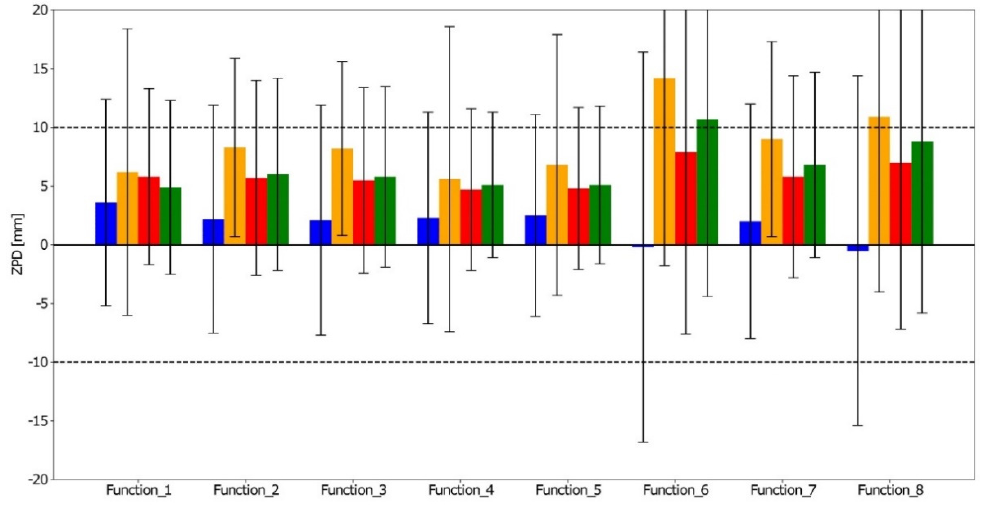
Figure 10. Mean accuracy of the ZPD with standard deviation from all stations and all periods for all analyzed weighting functions. Blue − E solution, orange − G solution, red − GE solution, green − GE1 solution.